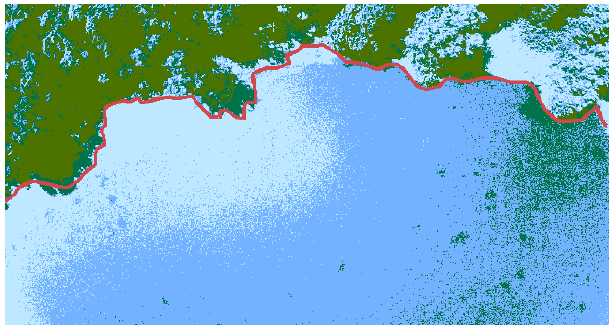
Fig. 6: Supervised classification in 7.7.2015, source: authors